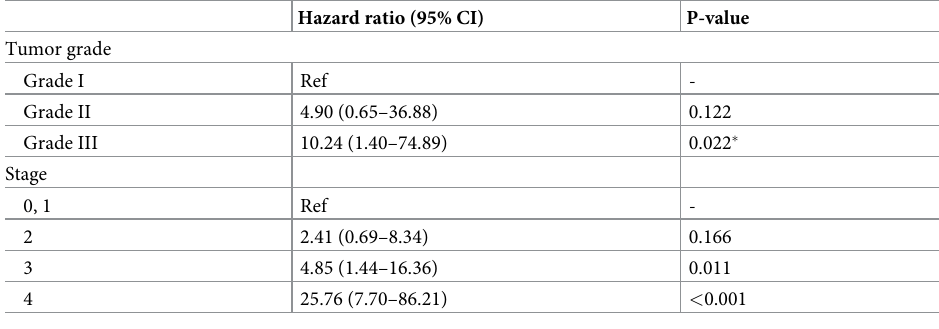
Table 3. Results of final multivariate of the Cox proportional hazard